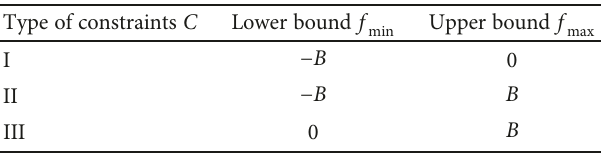
Table 2: The type of constraints of the frequency f as a function of the absolute value B ( B > 0